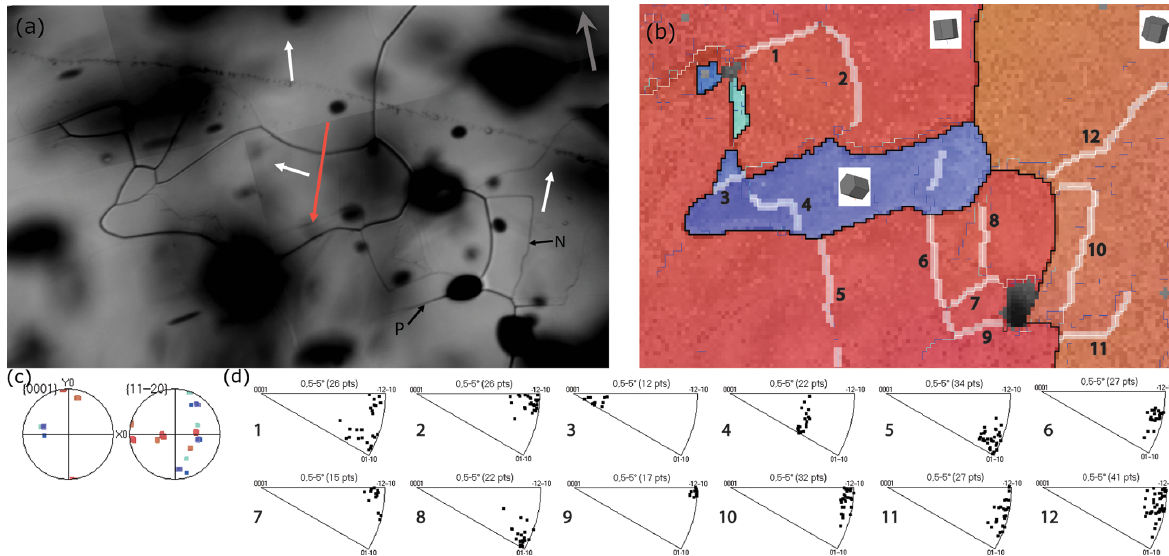
Figure 4. Microstructure analysis from NEEM sample. (a) LM microstructure map of sublimation-etched surface showing several GBs and SGBs. The vertical axis of the ice core is indicated by a dark grey arrow. The white arrows indicate the orientation of the c-axes. A P-type boundary and an N-type boundary are labelled as examples. The red arrow shows an SGB in LM that is not observed in the corresponding EBSD map. (b) Corresponding EBSD map showing SBG subsets labelled 1–12 and a schematic of the crystal orientation in the three grains shown. (c) Pole figure of the three grains shown in the EBSD map showing the c- and a-axes with the colour coding as in panel (b) . (d) Rotation axes of the SGBs